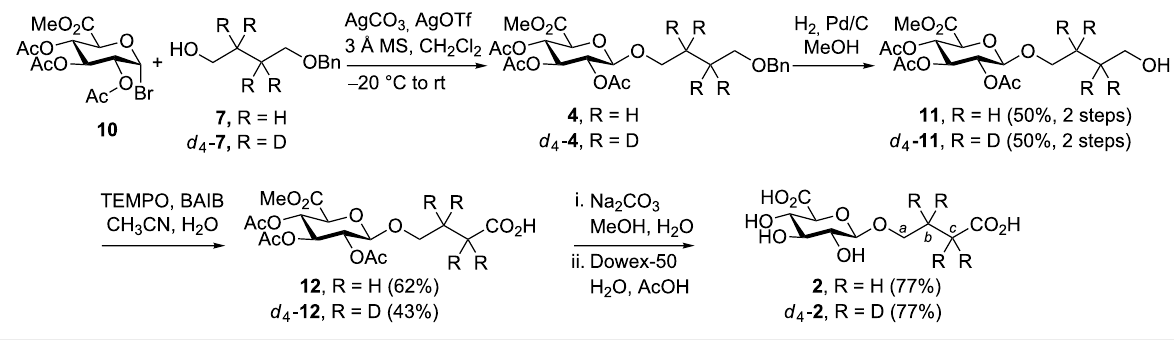
Scheme 3: Synthesis of GHB glucuronides 2 and d 4 - 2 by using a Koenigs–Knorr glucuronidation approach. TEMPO: 2,2,6,6-tetramethyl-1-piperidin- yloxyl, BAIB: [bis(acetoxy)iodo]benzene.